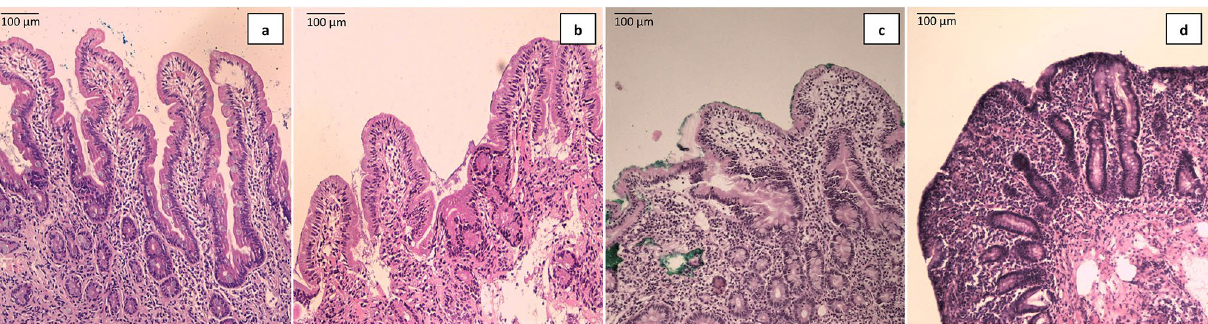
Figure 3. Histological images of villous height obtained using hematoxylin and eosin (H&E) stain. Representative pictures of—( a ) Normal villous architecture ( b ) Mild villous atrophy ( c ) Subtotal villous atrophy ( d ) Total villous atrophy with crypt hyperplasia.